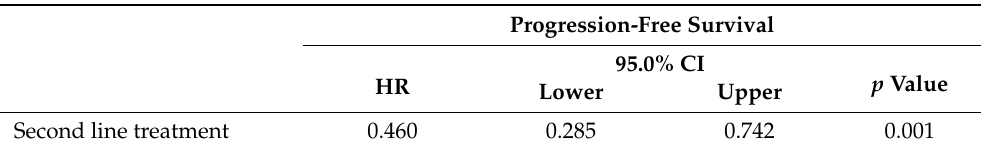
p ValueLower Upper